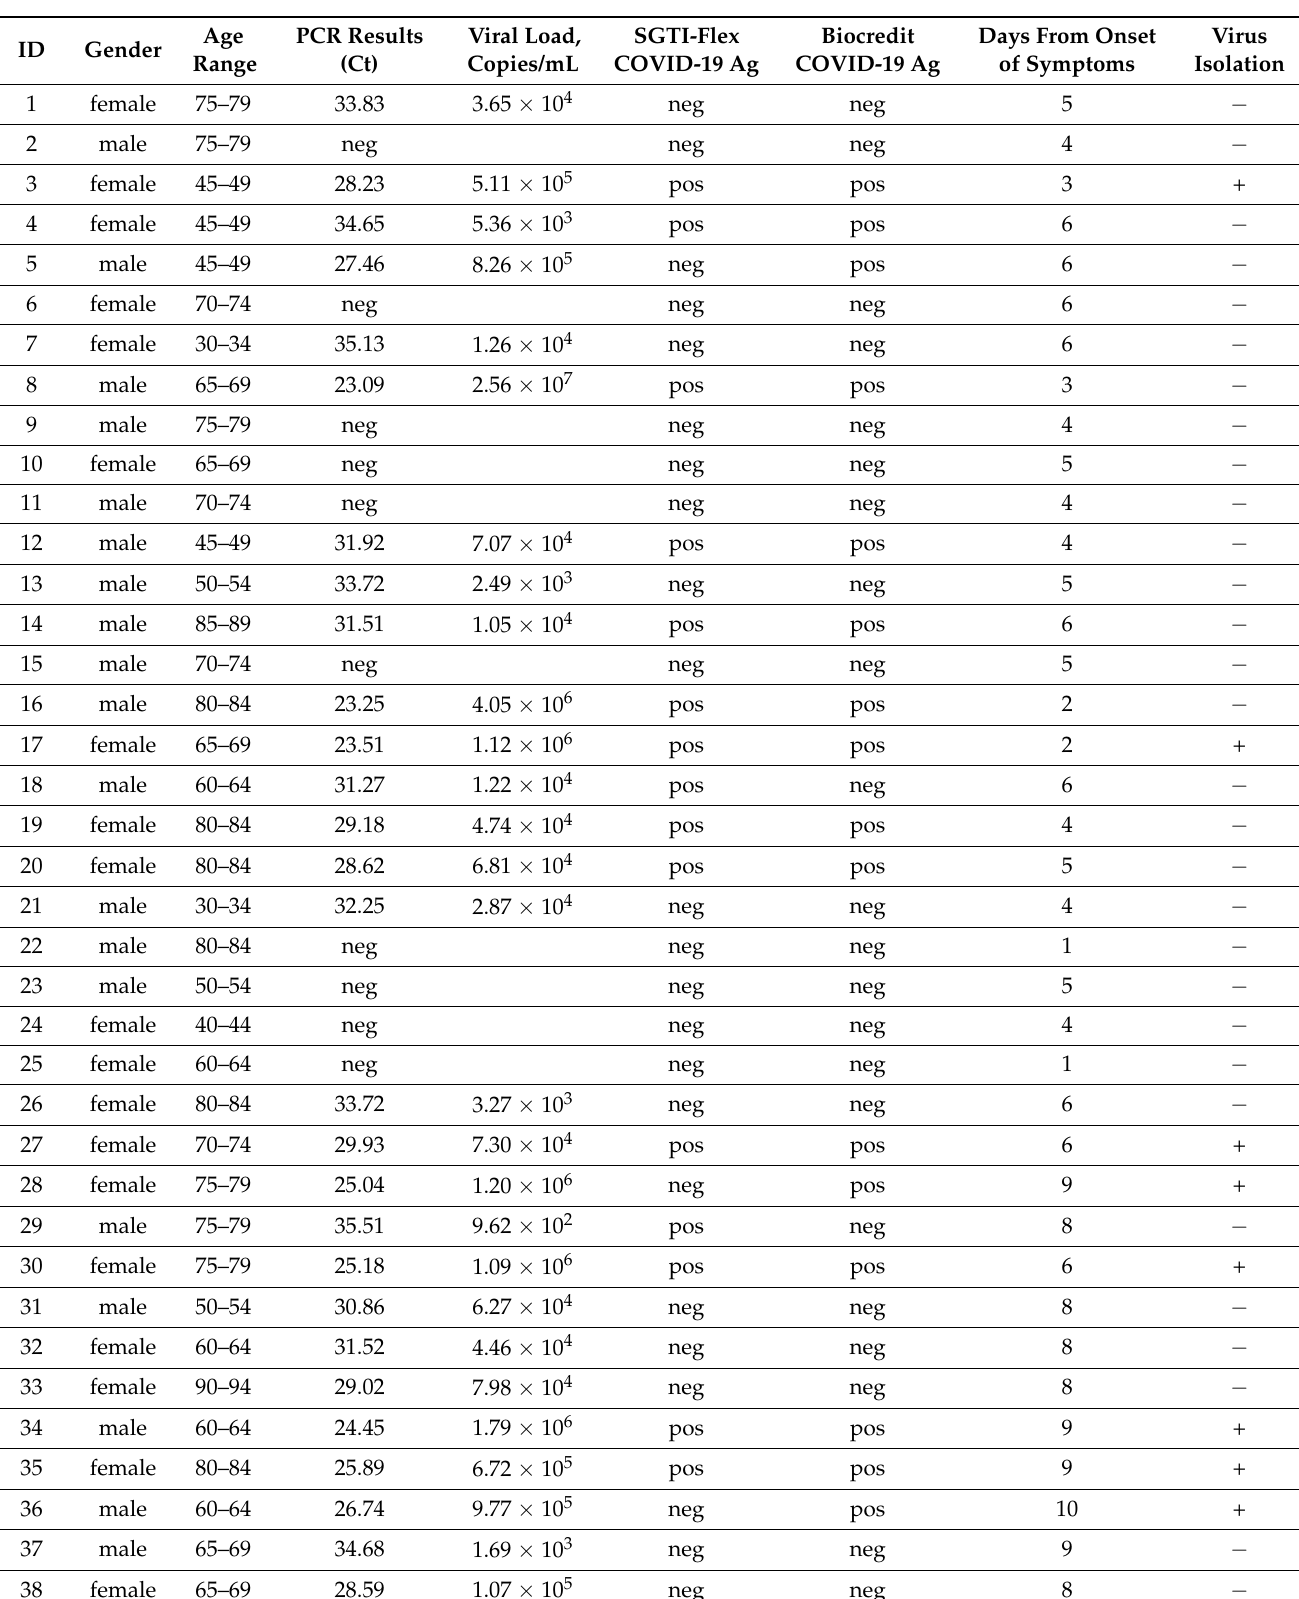
Table A2. Baseline data for all